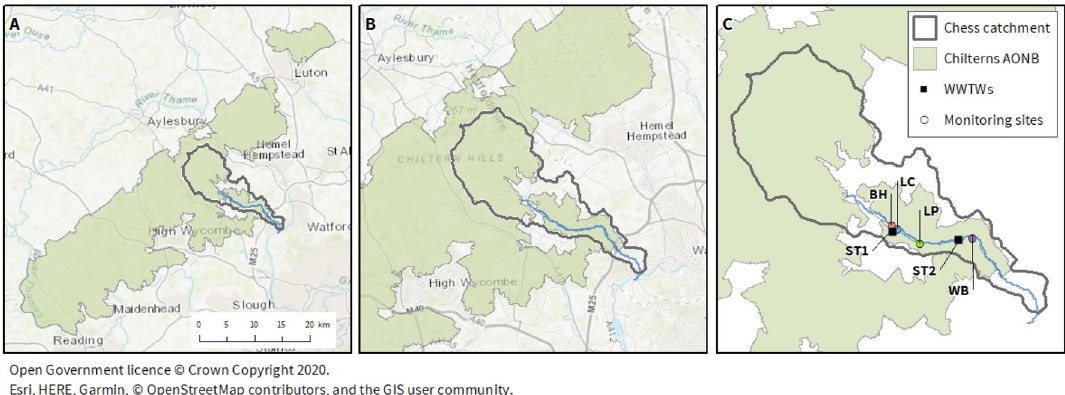
Figure 13. Map showing location of ( a ) Chiltern Area of Outstanding Natural Beauty (AONB) in South East England ( b ) River Chess flowing from the Chilterns AONB; and ( c ) the four monitoring sites in the River Chess: BH, LC, LP and WB. ST1 and ST2 indicate the location of the two Wastewater Treatment Works on the river. Maps created using open data from OpenStreetMap available under the Open Database License, see 67 for